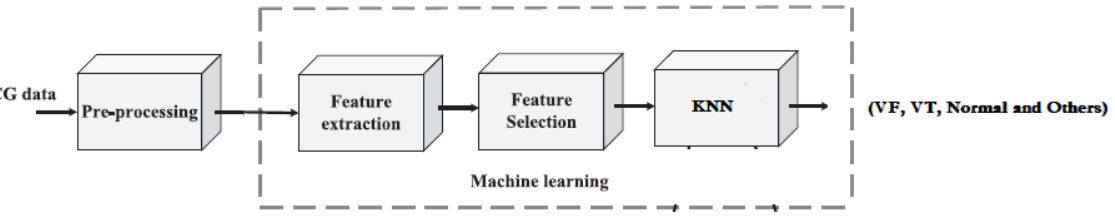
Figure 5. Schematic diagram illustrating the feature selection process proposed for the discrimination of ventricular arrhythmias, normal sinus, and other types of